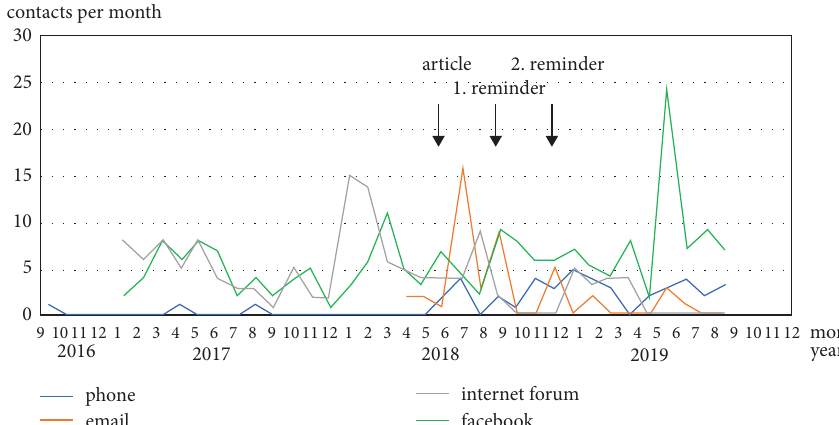
Figure 2: First contacts to the German self-help group per month. Distribution of all 411 frst contacts to the German self-help group from 09/2016 to 09/2019 by diferent communication channels and in relation to the publications of the awareness campaign. After publication of the article the number of frst contacts to the German self-help group via phone calls and emails increased. Mentioning the publications of the awareness campaign in the independent (patient led) closed facebook ® group also led to a higher number of activities. Due to mainly technical reasons the documentation for the whole period is only complete for frst contacts by phone. Te period of documentation is limited from 04/2018–09/2019 due to a hard drive problem of the self-help group in spring 2018. Documentation of the new contacts by internet forum and facebook ® started in 1/2017, however, it was stopped preterm for the internet forum due to a crash of the forum in spring